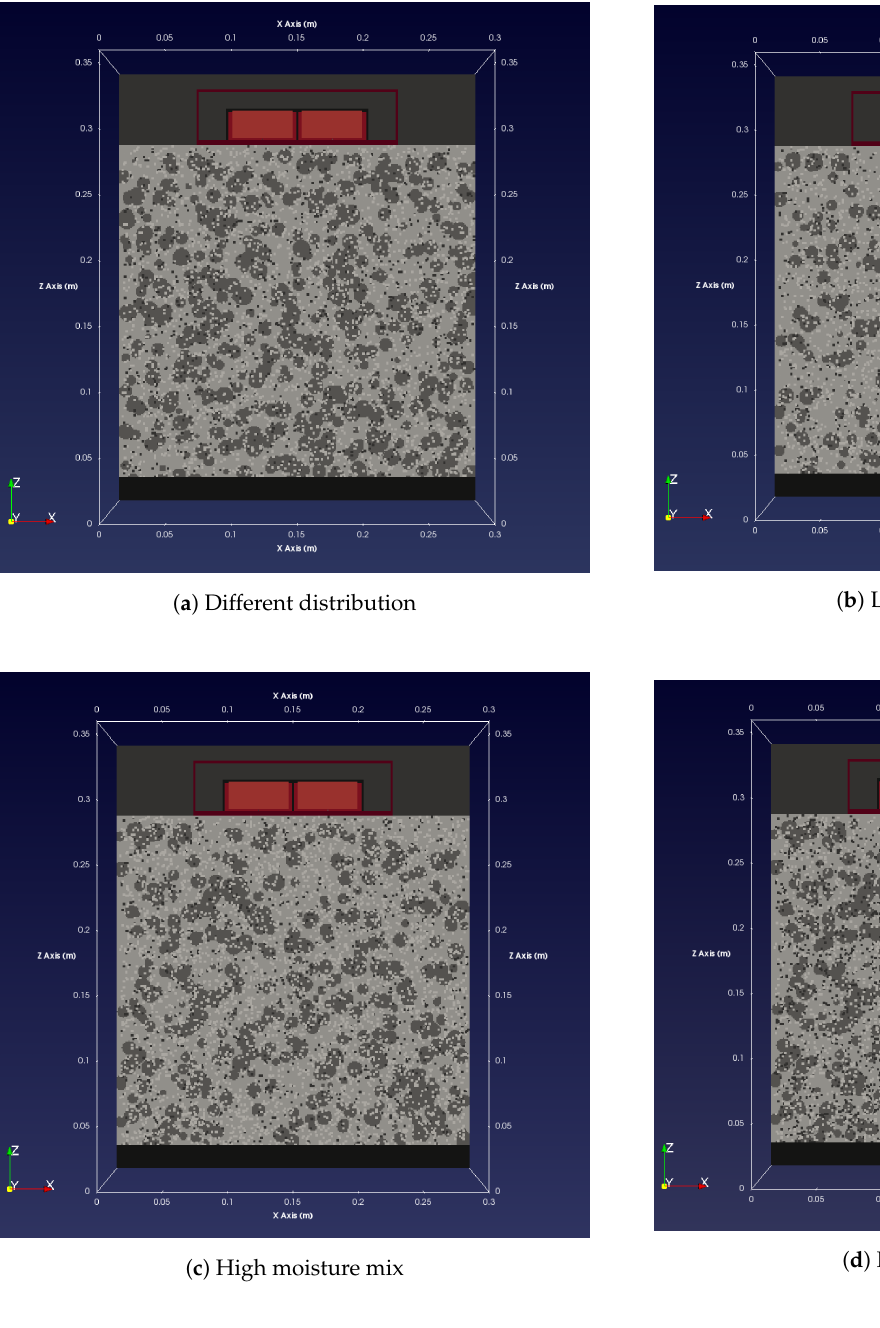
Figure 4. Heterogeneous concrete mix with different aggregates, air-voids and moisture content. ( a ) presents the same mixture content as ( b ) but with different distribution. ( b ) shows a mixture with low aggregate content. ( c ) illustrates high moisture content concrete resulting in a high permittivity. Finally, ( d ) indicates high air-void content allowing the GPR signal to travel with a higher velocity. 64 representative concrete mixtures were selected from the training pool and each one was simulated 50 times resulting in 3200 simulations. The red box corresponds to the numerical equivalent of the GSSI 1.5 GHz antenna structure. The volumetric percentages of the components for each model are shown in Table